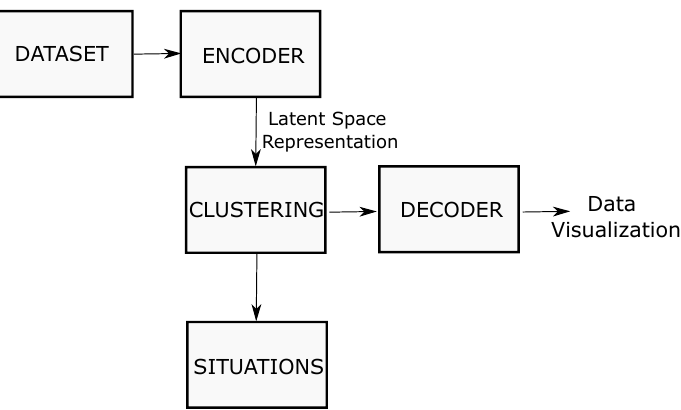
Figure 2. Workflow of the unsupervised methodology to automatically classify the situations.